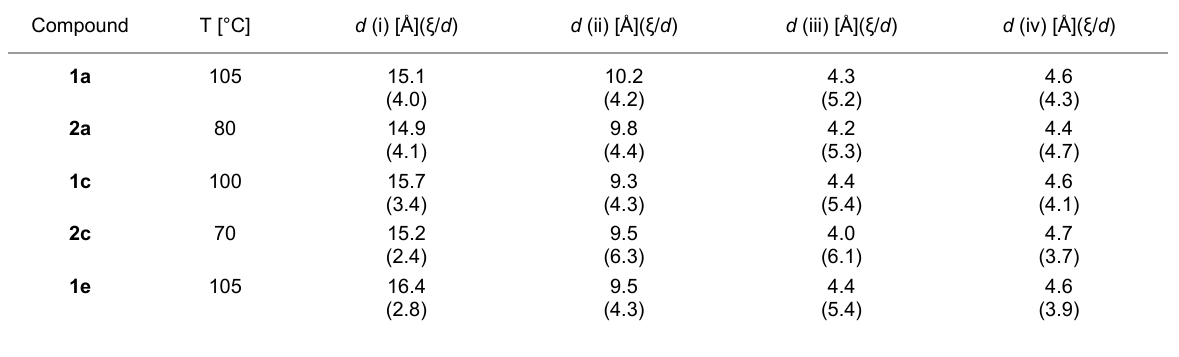
Table 2: X-ray diffraction data. The correlation length ξ was estimated from the half width of the reflections by using the Scherrer formula [33,34].